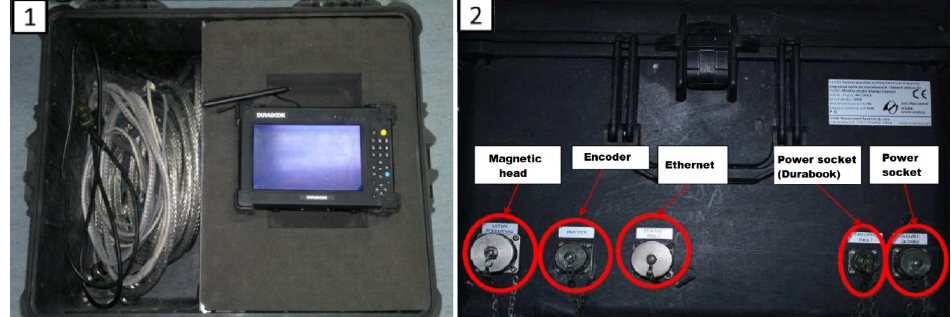
Figure 5. HRDS system data acquisition module: Durabook tablet and CompactDAQ ( 1 ); plugs installed in the box ( 2